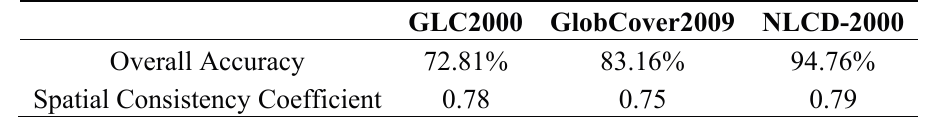
Table 7. Accuracy